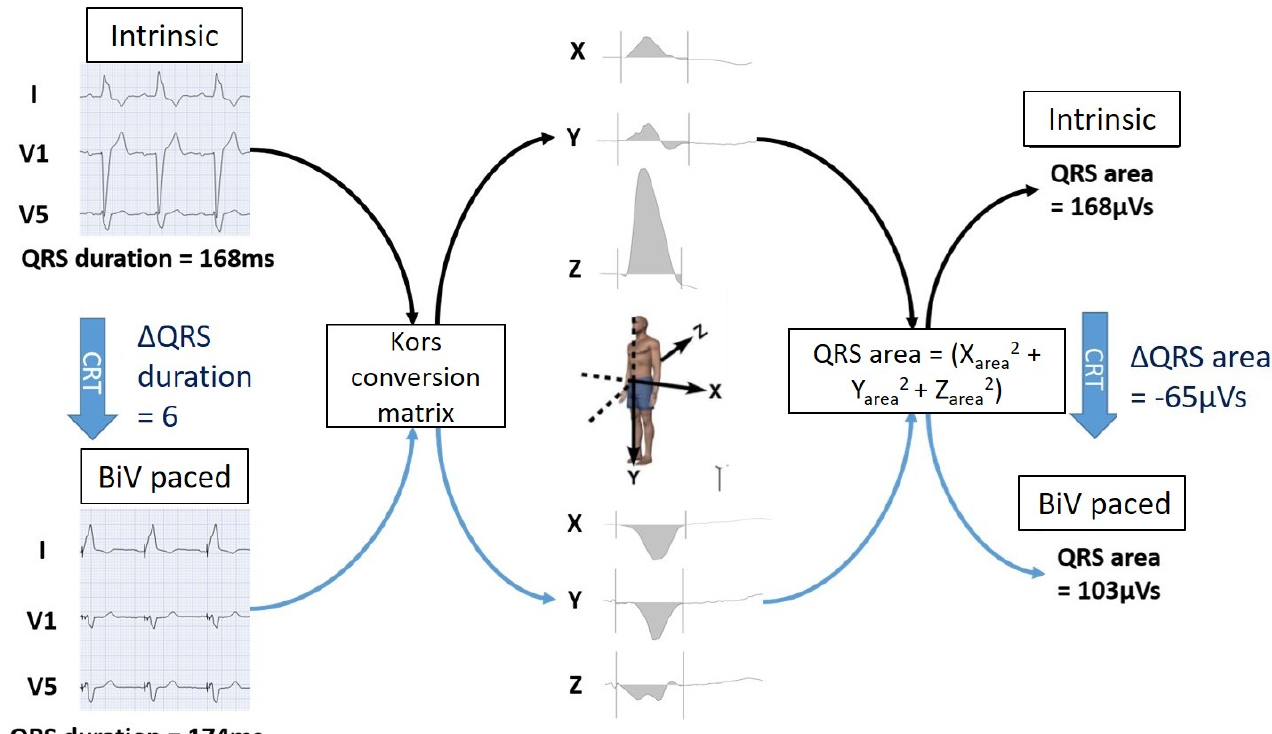
Figure 1. Transformation of ECG to VCG and calculation of ( ∆ ) QRS area. The 12-lead ECGs are mathematically converted in VCGs with the three orthogonal X-, Y-, and Z-leads using the Kors matrix. The X-, Y- and Z-leads of a patient with intrinsic rhythm and with CRT-pacing are shown. QRS area is calculated from the three orthogonal leads using the formula presented. As shown in this example, QRS area does not necessarily correlate with QRS duration. VCG = vectorcardiogram; CRT = cardiac resynchronization therapy. BiV pacing = biventricular pacing. Reprinted with permission from [8] Copyright © 2021 The Authors.